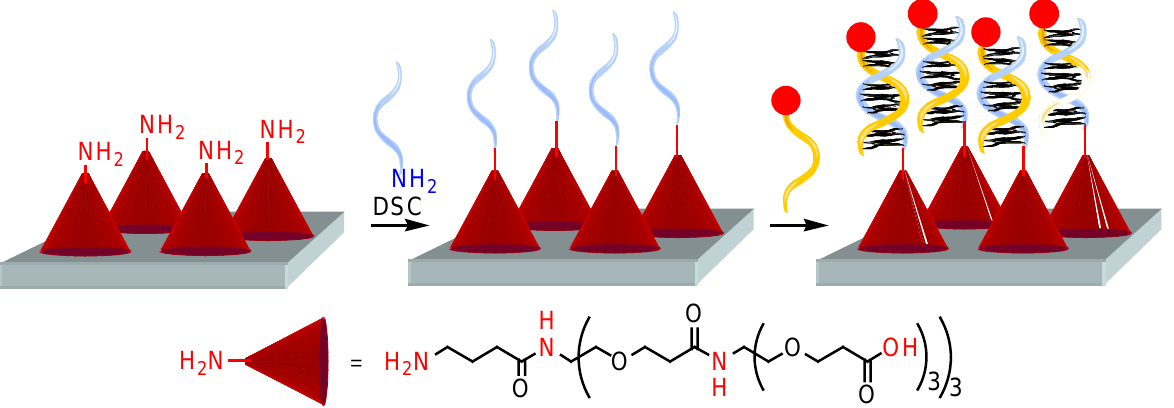
Figure 12. Dendrons grafted to a solid substrate by their surface groups, generating mesospacing; coupling of amine-tethered oligonucleotide through DSC linker. High hybridization yields are obtained with this nanostructured